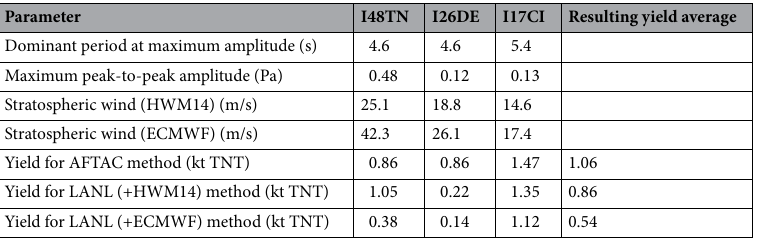
Table 2. Parameters and results for infrasound-based yield estimation using different IMS arrays and methods. The effective wind speeds are averaged along the great-circle propagation paths between source and receivers.